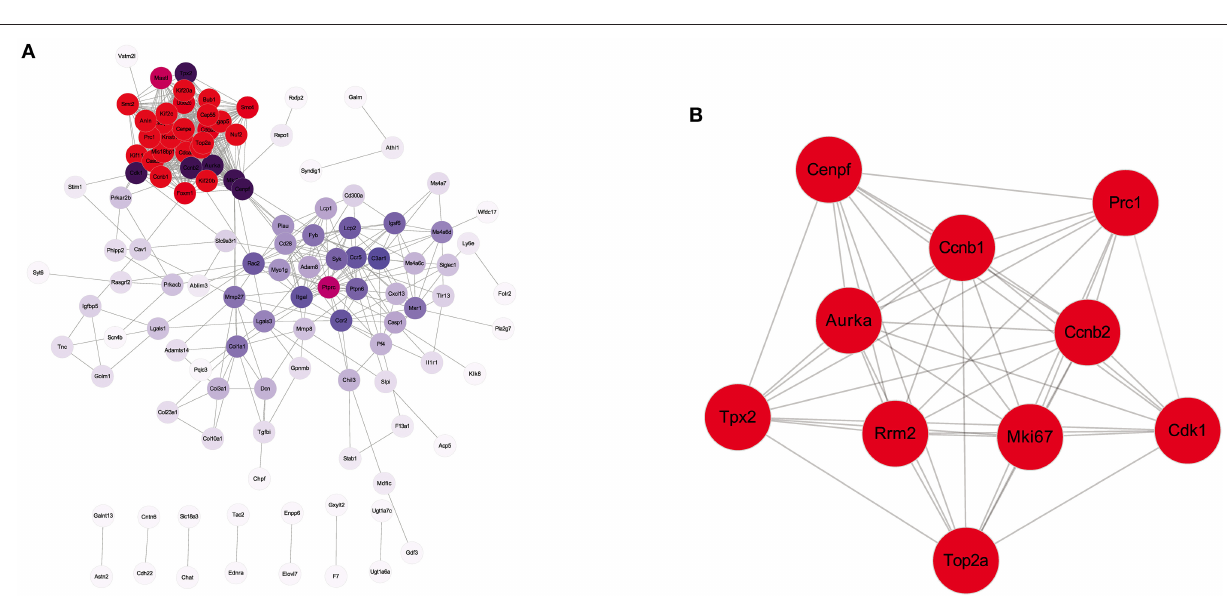
FIGURE 5 | Protein–protein interaction (PPI) network analysis of the DEGs identified from EA + MCAO vs. MCAO group. (A) PPI network of all the DEGs. (B) The interaction network of top 10 hub genes. n = 3 mice/group.